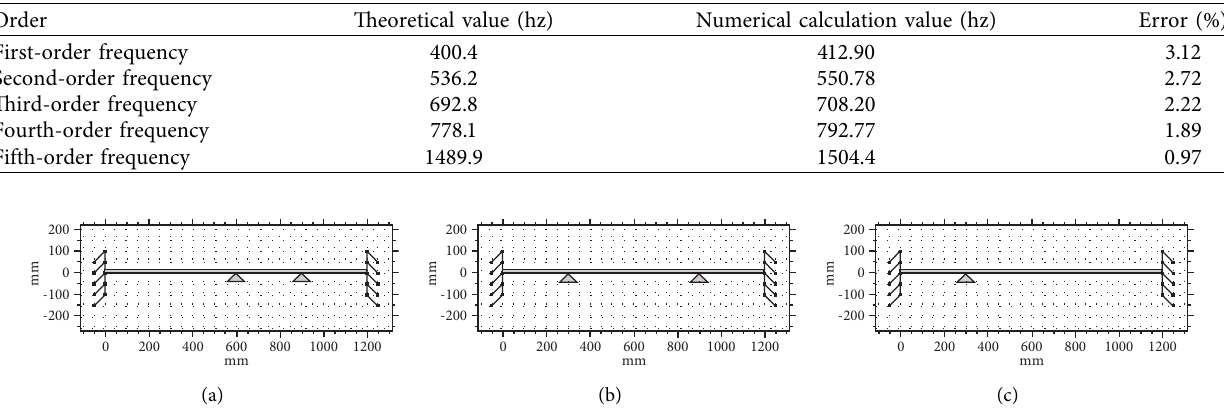
Figure 4: Unequal span tube bundle model diagram. (a) “011” type. (b) “101” type. (c) “100”